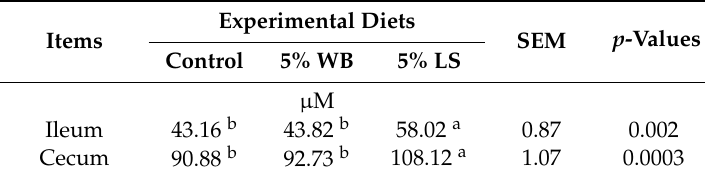
Table 4. E ff ects of LS supplementation on the lactate concentration of the intestinal content of 35-day-old broilers 1